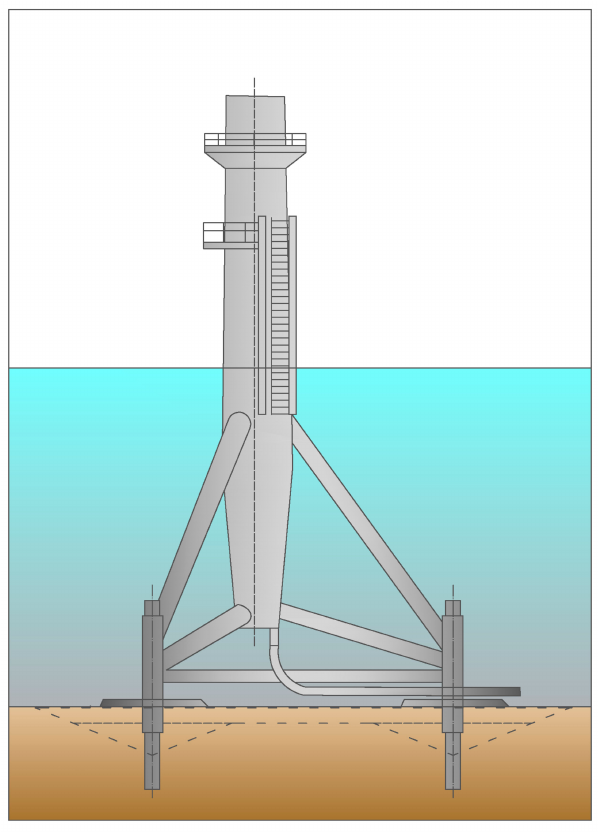
Figure 5. Tripod structure scheme, based on